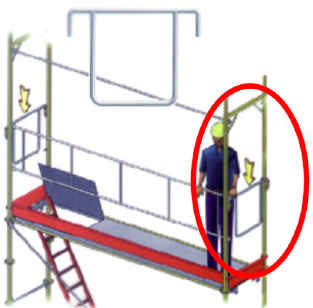
Figure 1. “Standardized scaffolding” or “system scaffolding” (Modular frame scaffolding) [10].